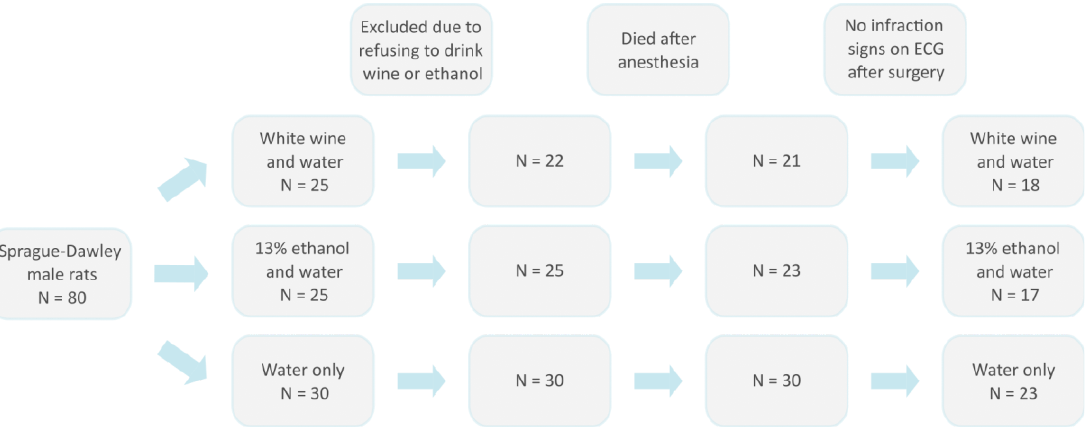
Figure 1. A flow diagram for rats included in the study. All animals were raised in the Experimental Animal Facility of the University of